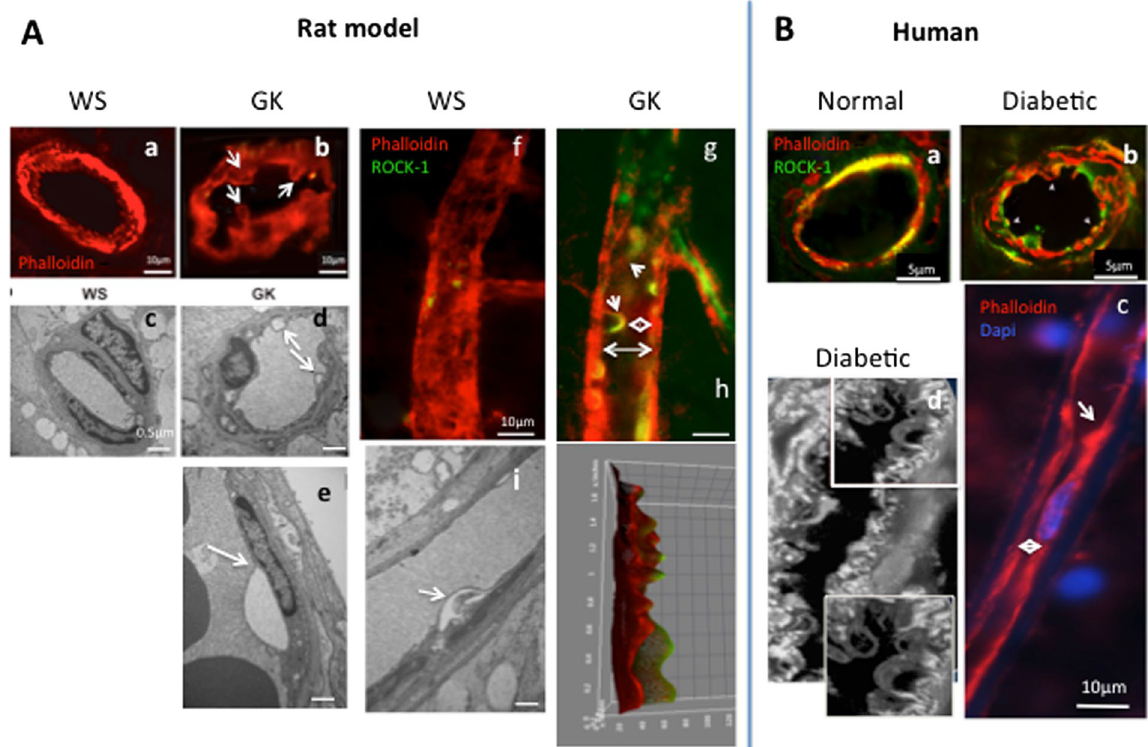
Figure 2. ROCK-1 distribution and blebbing in endothelial cells of diabetic retinal vessels. ROCK1-phalloidin double staining (ROCK-1 in green, phalloidin in red) on: ( A ) Rat retina, ( B) Human retina. Endothelial cell blebbing is identified by actin staining only in GK rat retinal vessels ( A ,a–b). TEM confirms cytoplasmic protrusions with double layered membrane and normal nuclei in GK rats vessels and not in WS rats ( A ,b–e). In GK rat vessels, ROCK-1 is distributed at the endothelial cell membrane and surrounds the endoluminal blebs ( A ,g arrows) that reduce the lumen ( A ,g, double arrow). 3D representation of ROCK-1 and phalloidin staining clearly show the membrane protrusions co-stained with ROCK-1 and phalloidin ( A ,h). In vessels from a normal human retina, ROCK-1 co-localizes in the cytoplasma of endothelial cells in retinal vessels ( B ,a), but is translocated at the membrane and in blebs in endothelial cells from a diabetic human retina ( B ,b), where intense blebbing can be observed ( B ,c) narrowing the vessel lumen. Scale bar = 10 µ m, for TEM scale bar = 0.5 µ